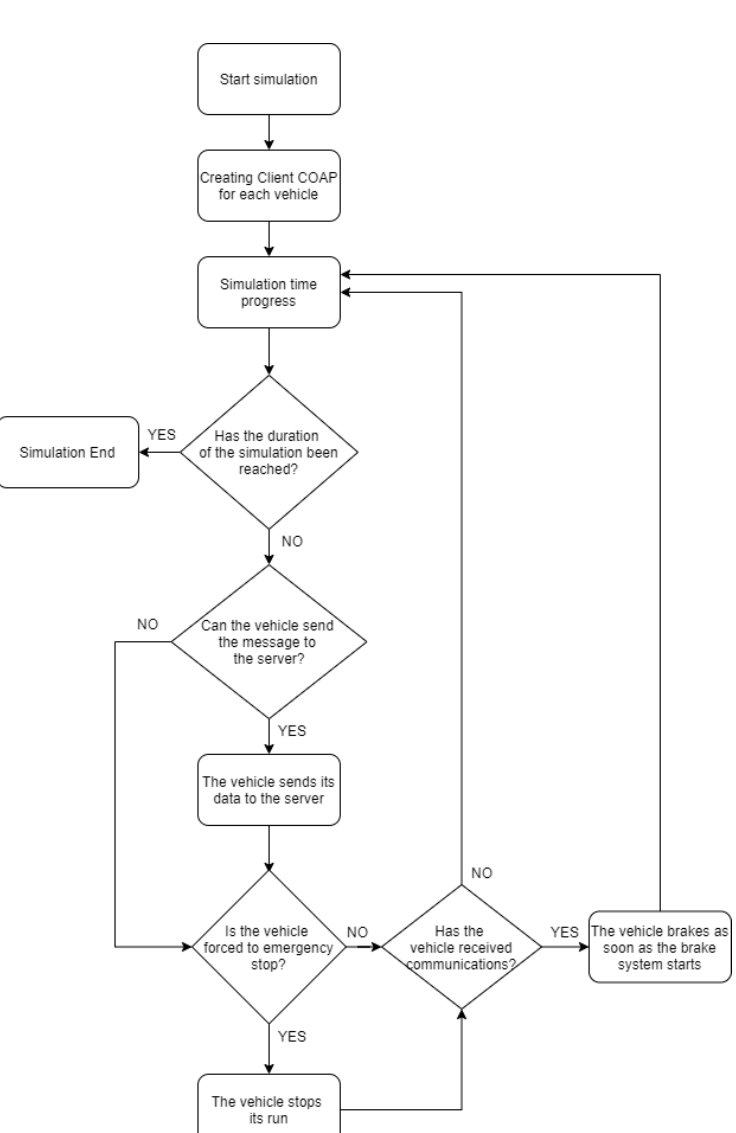
Figure 6. Flow chart of vehicle